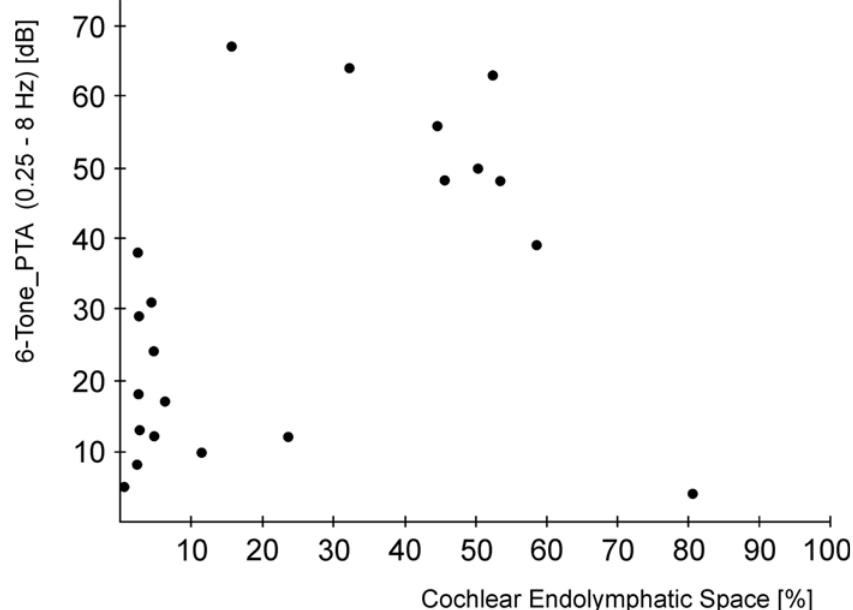
Fig 4. Correlation between 6-tone pure-tone-audiometry (6-Tone_PTA) and percentage of vestibular endolymphatic space to total labyrinth fluid (Vestibular endolymphatic space/total labyrinth volume x